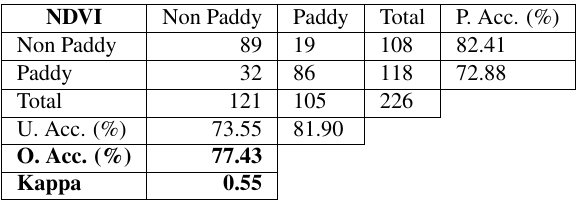
Table 2: Accuracy assessment of NDVI-based rice acreage map- ping